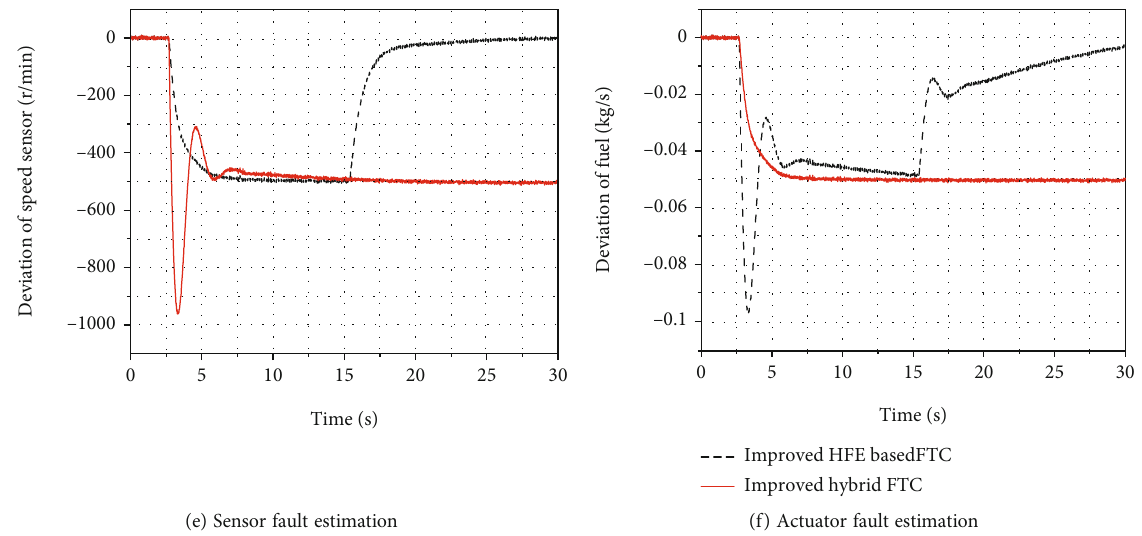
Figure 16: Comparison of experimental results between the improved hybrid FTC system and the improved HFE-based FTC